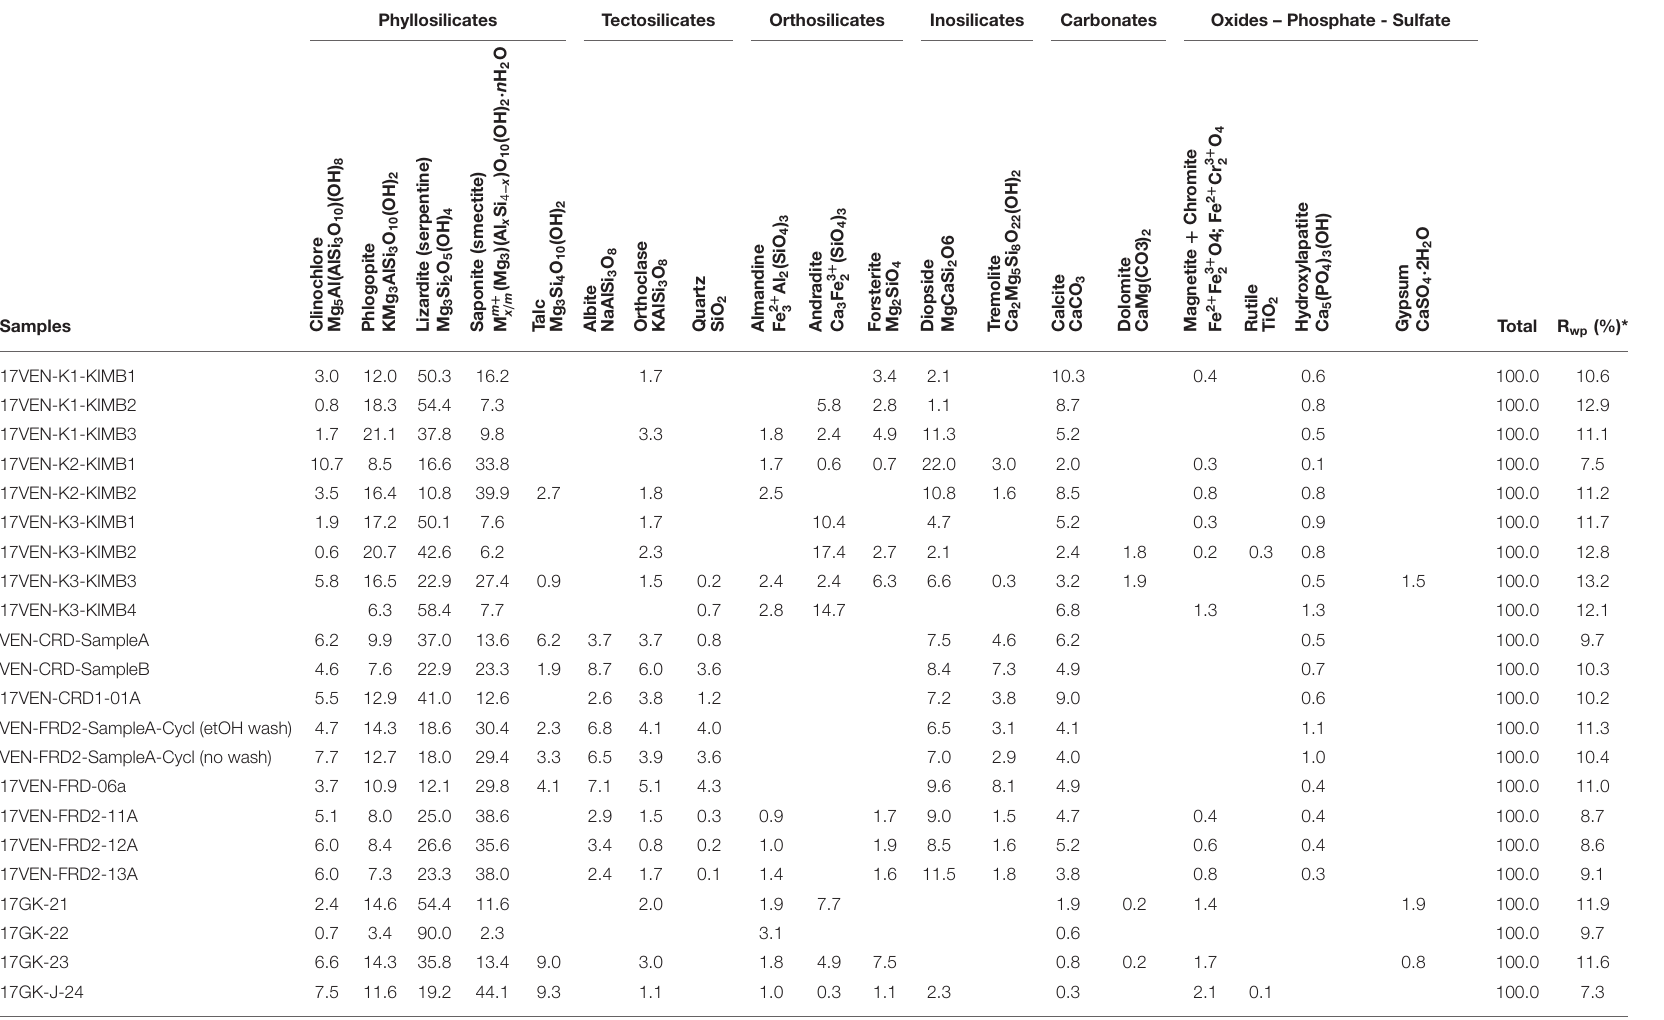
TABLE 2 | Quantitative mineralogy results from Rietveld